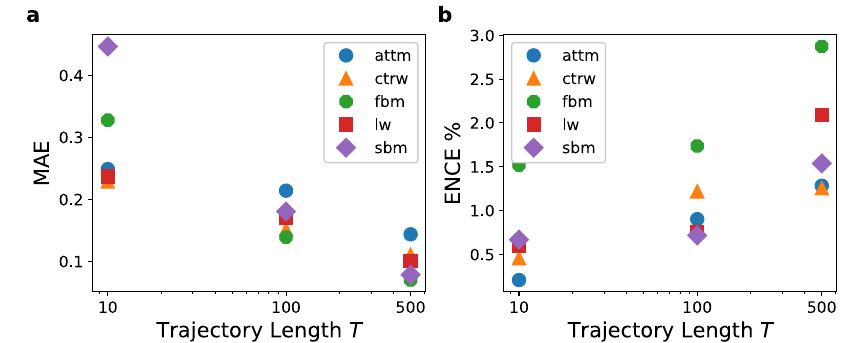
Fig. 4 | Performance evaluation for regression when the underlying model is known. a Mean absolute error (MAE) and b expected normalised calibration error (ENCE) 82 achieved by the Multi-SWAG models trained on only one model, plotted for different trajectory lengths T by averaging over 5×10 4 (FBM, SBM) or 4×10 4